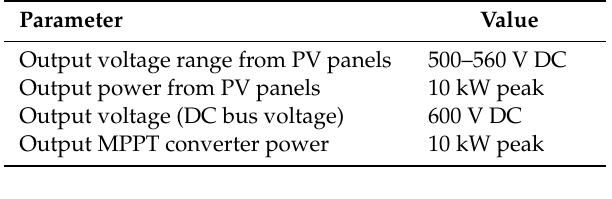
Table 1. Operational parameters of target application reflecting the situation from Figure 1.